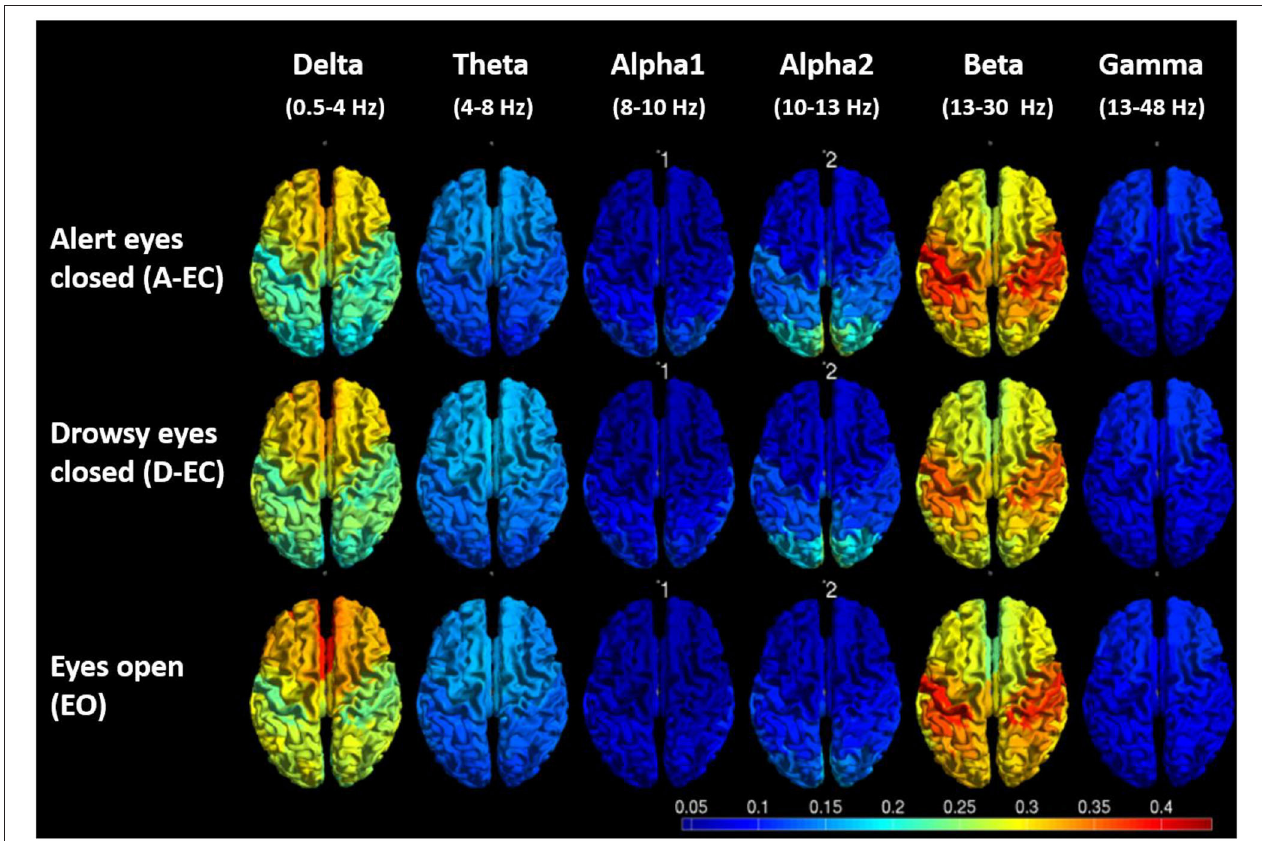
FIGURE 4 | Visual representation of the average relative power values (5 epochs for 19 subjects) for different frequency bands and different conditions/states. Note the lower posterior alpha2 power EO vs. A-EC, the higher frontal delta power EO vs. A-EC, the lower central beta power D-EC vs. A-EC and higher central and frontal theta in D-EC vs.